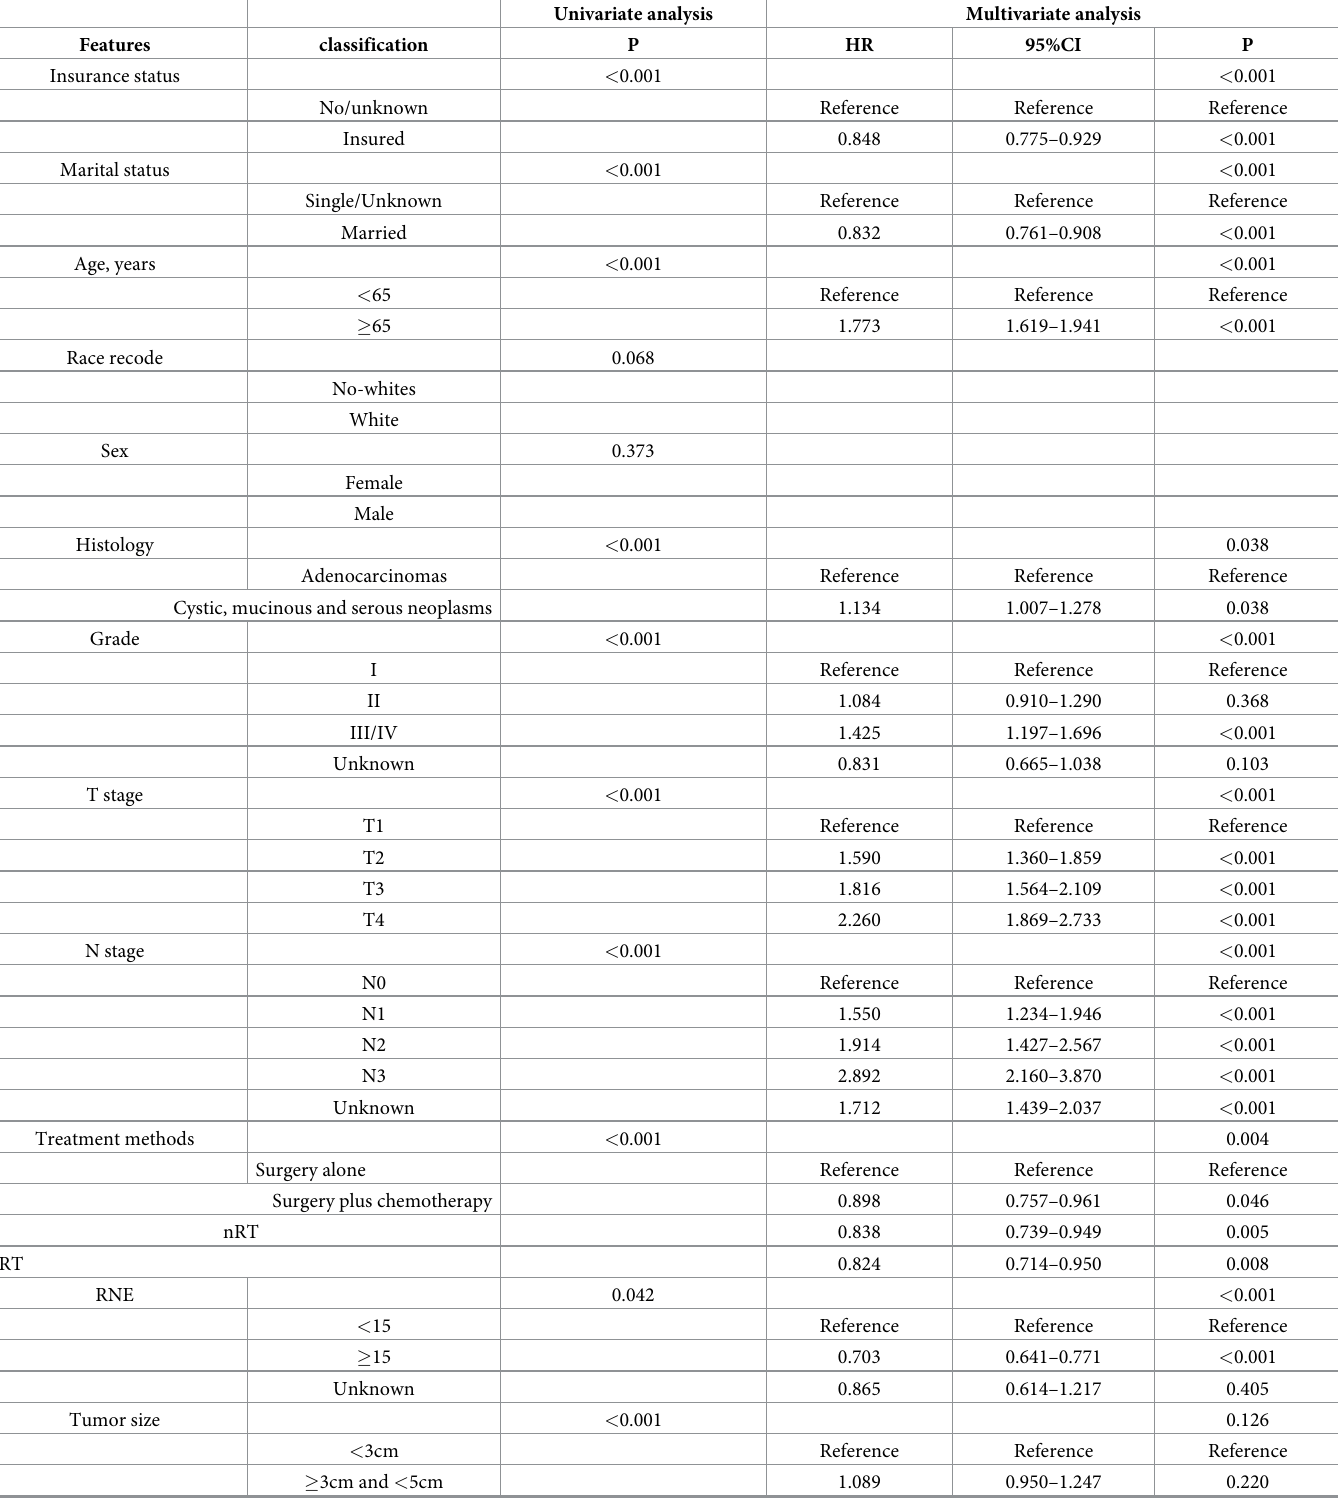
Table 2. The Cox regression model analysis for OS of all Siewert type II GEA